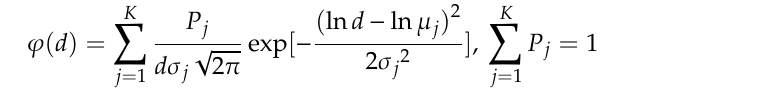
Table 1. Pore structure parameters and the effective diffusion coefficient.